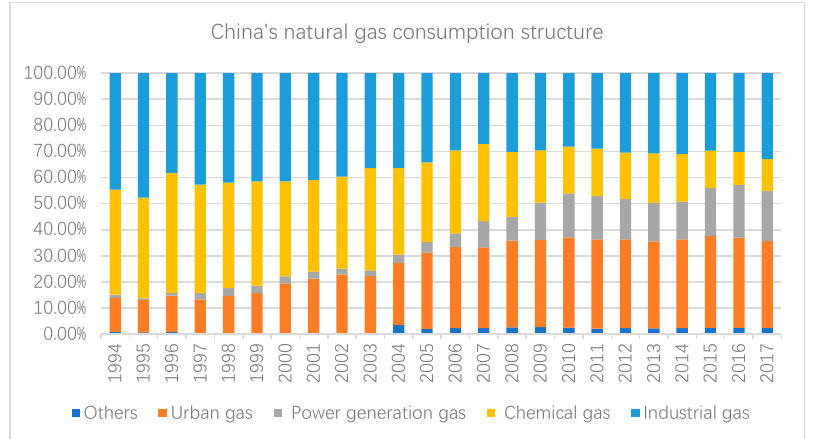
Figure 1. China’s natural gas consumption structure.